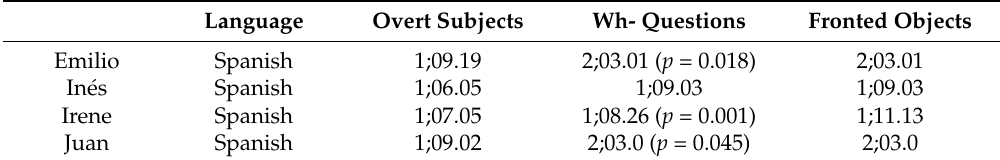
Table 2. Ages of onset and binomial test result of overt subjects, wh- questions and fronted objects in 4 Spanish-speakers, compiled From Villa-Garc í a and Snyder (2009, Tables 2 and 3, pp. 6–8).